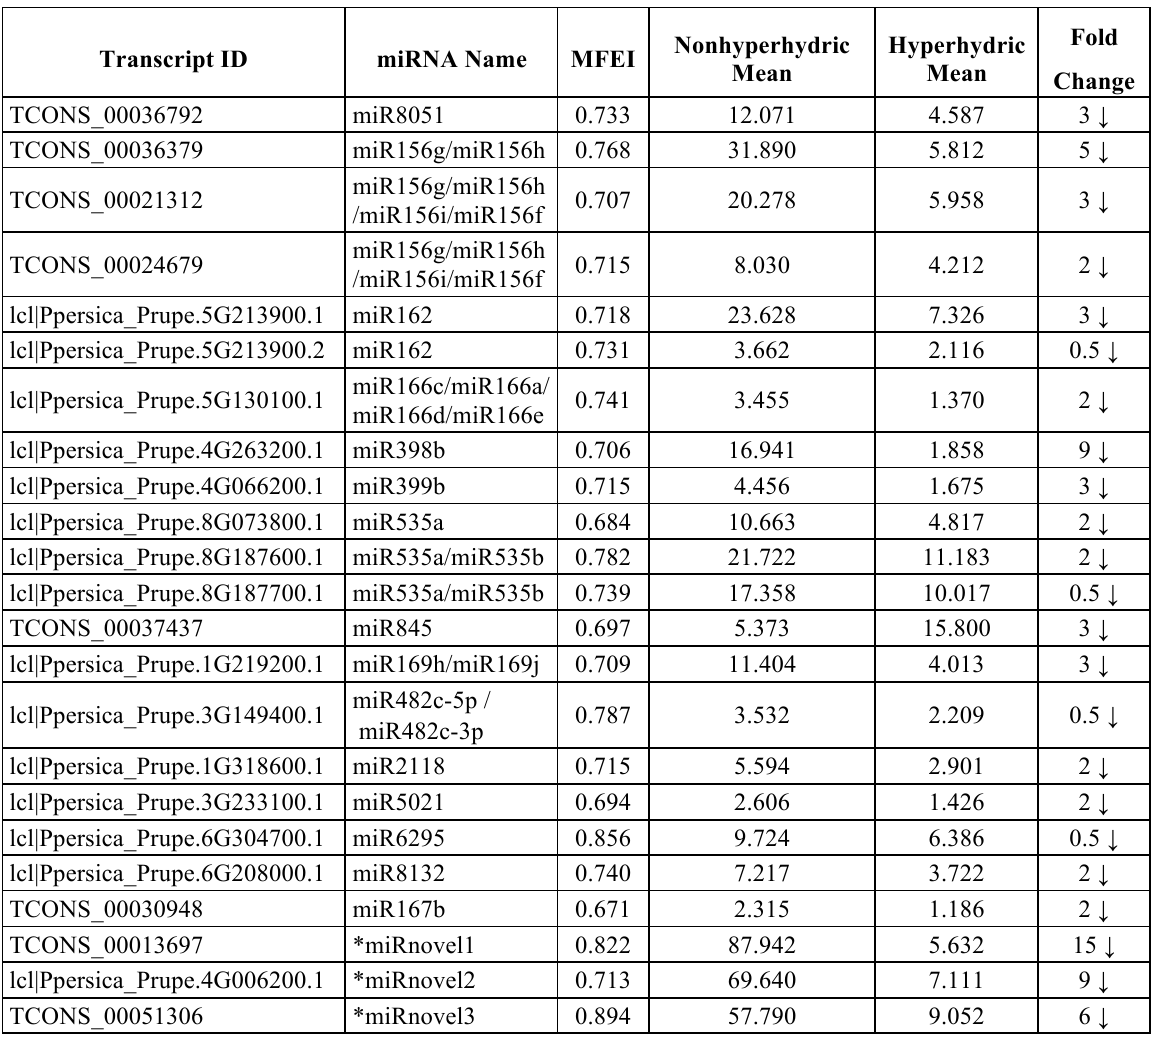
Table 2: Differential expression levels and MFE indexes of miRNA precursors. MFEI: Minimum Free Energy Indexes of the transcripts; non-hyperhydric Mean; mean of normalized